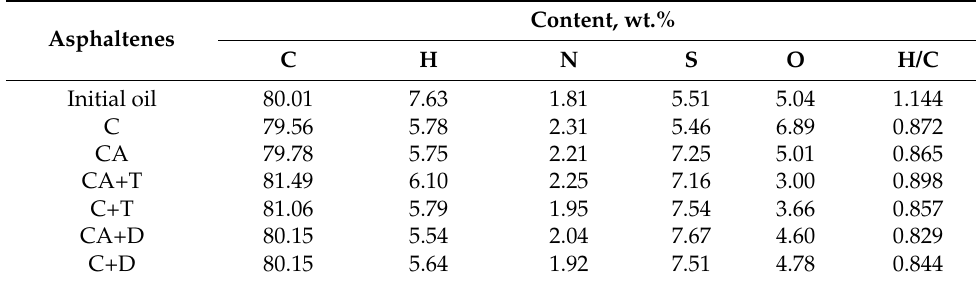
Table 2. Elemental composition of initial asphaltene and after catalytic aquathermolysis of heavy oil. Asphaltenes